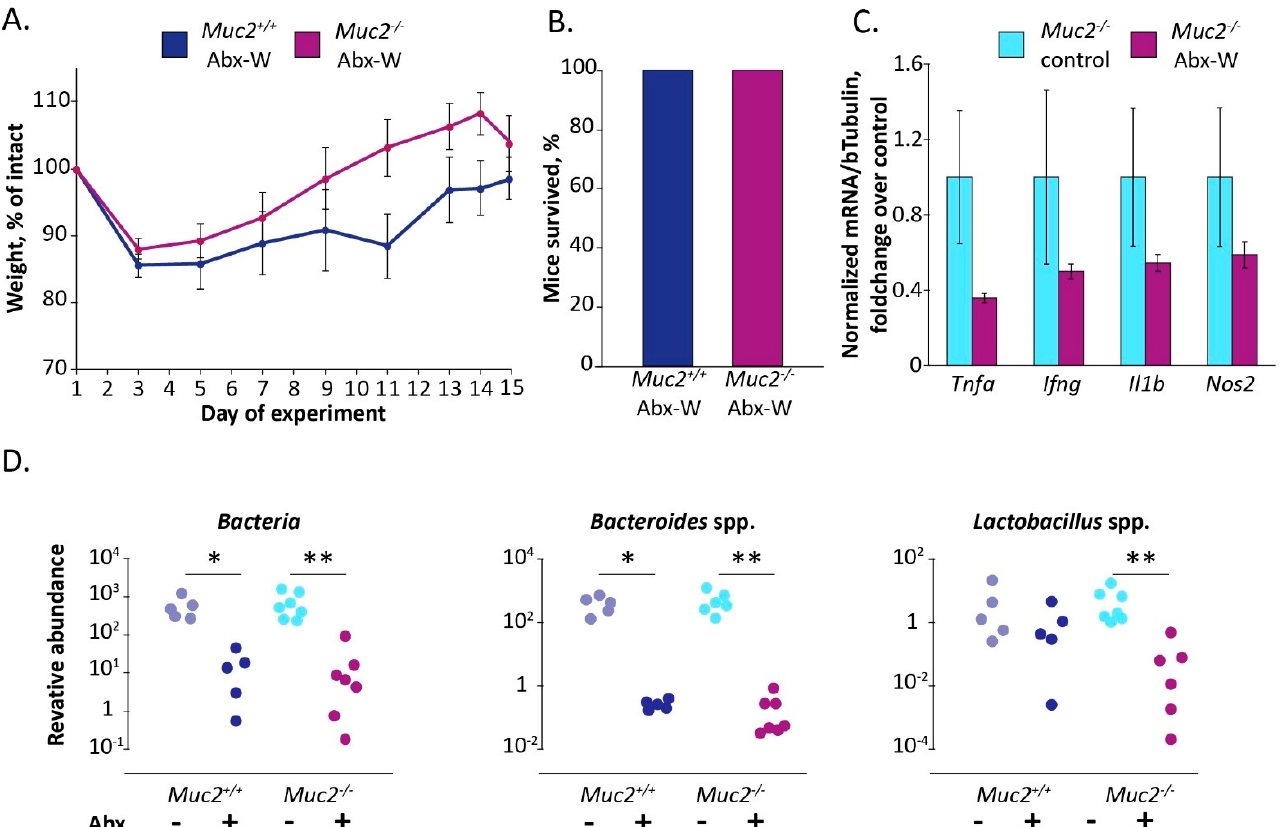
Figure 3. Muc2 − / − mice free of the infections survive after the antibiotic treatment. ( A ) Body weight dynamics upon antibiotic treatment. ( B ) Survival rate. ( C ) Gene expression in colon tissue normalized on beta Tubulin (Tubb5) gene. ( D ) Relative abundance of the gut bacteria in feces on the day 15, normalized on Mus musculus 28S rRNA gene. *, **—differences between groups p < 0.05, p < 0.01, Mann–Whitney u-test. Experimental groups: “Abx-W”—treatment with the antibiotics by adding in drinking water.